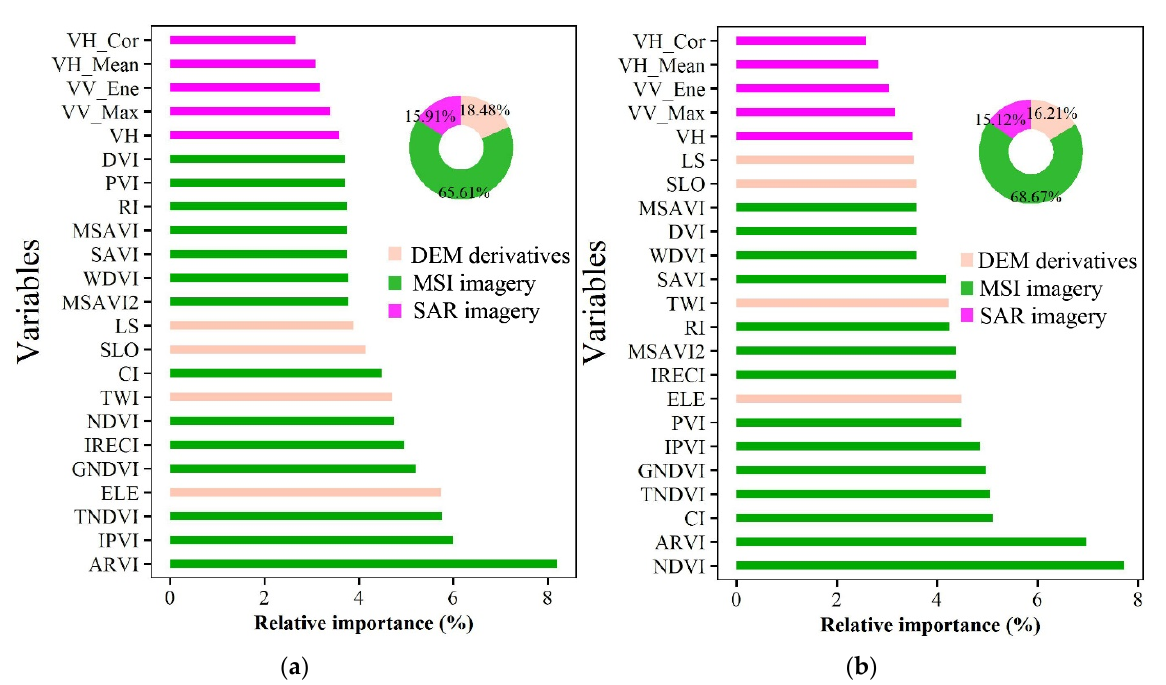
Figure 7. Contributions of the variable covariates to forest LAI estimation in Xingguo ( a ) and Gan- dong ( b ). Gandong ( b